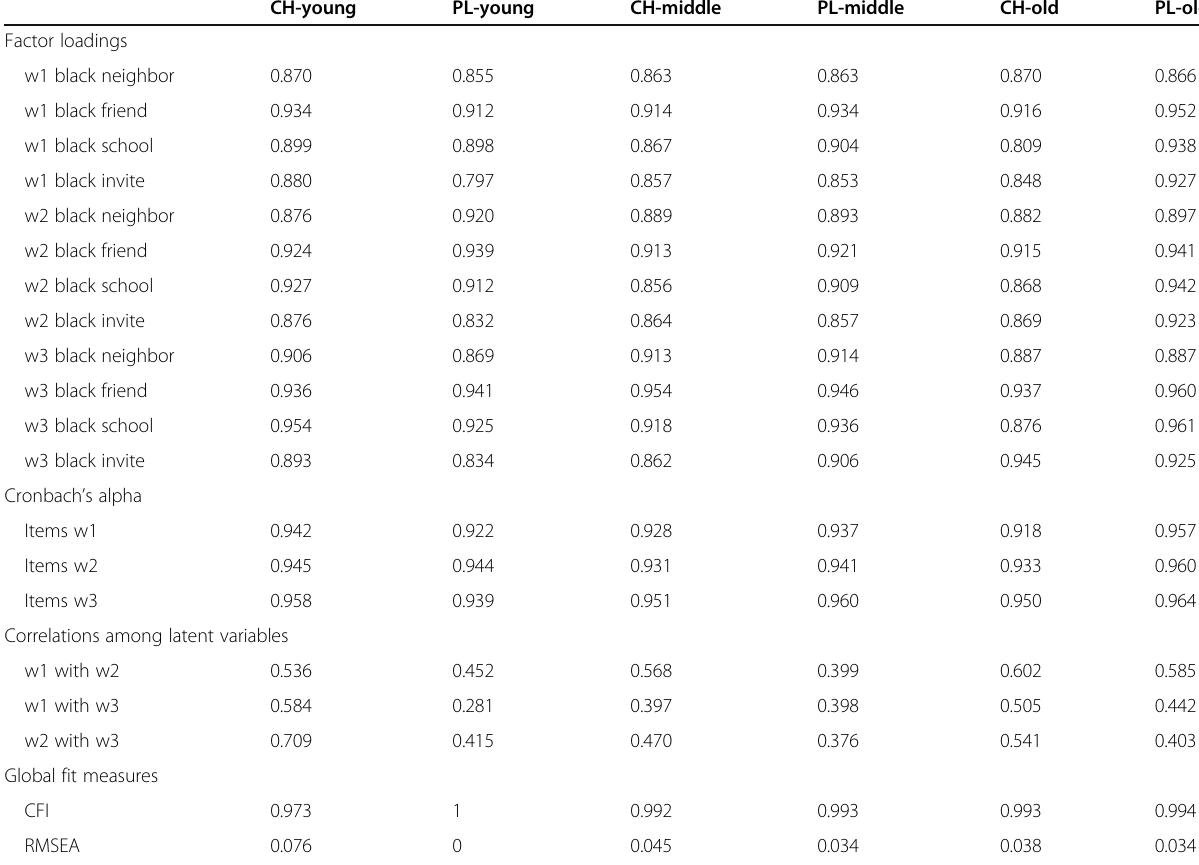
Table 5 SCFA models for attitudes toward black immigrants modeled separately across age cohorts and countries (configural model) (with standardized factor loadings)